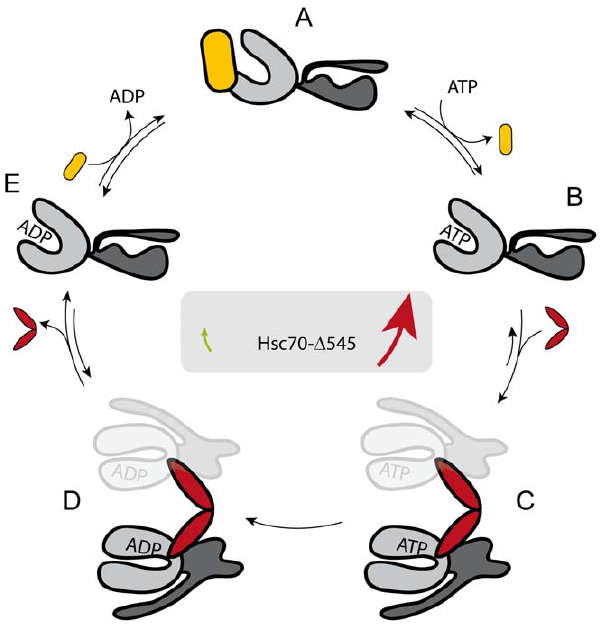
Figure 7. A model for the regulation of CeHsc70’s ATPase by the lid domain. A structural hypothesis for the regulation of the CeHsc70 ATPase cycle may be formulated based on the structures 2KHO of DnaK ( 74 ) and 3D2E of the Hsp70-homolog protein Sse1 ( 75 ). After initial binding of ATP to the NBD of CeHsc70 (Step A R B), conformational changes result in a hydrolysis competent conformation (Step B R C). This reaction is favored in CeHsc70, as evident from the observation, that hydrolysis is not rate-limiting. The helical lid likely regulates the equilibrium or the kinetics of the B R C transition, as this reaction appears to be much slower in CeHsc70- D 545. DNJ-13 (red) accelerates the formation of the hydrolysis-competent conformation and thus promotes ATP hydrolysis. ATP hydrolysis likely is irreversible (Step C R D). After hydrolysis, DNJ-13 leaves the complex and Hsc70 returns to its open conformation (Step D R E). BAG-1 (yellow) acts to displace the nucleotide (Step E R A). Based on this model, simultaneous BAG-1 and DNJ-13 binding to CeHsc70 would be mutually exclusive, although several intermediate steps might exist during this sophisti- cated